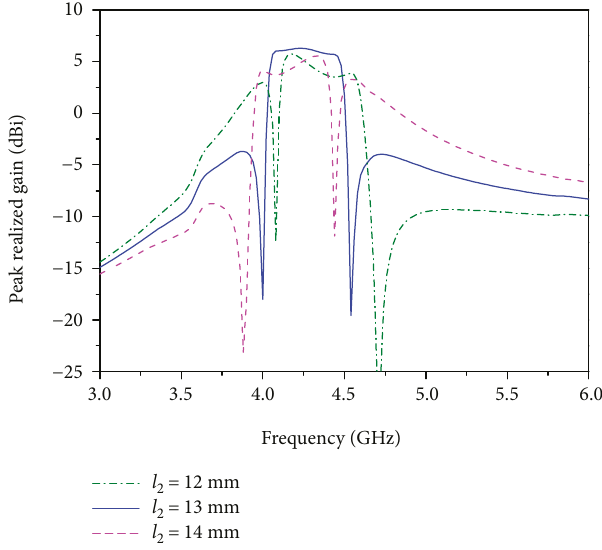
Figure 8: Simulated peak realized gain of Ant. 3 with di ff erent l